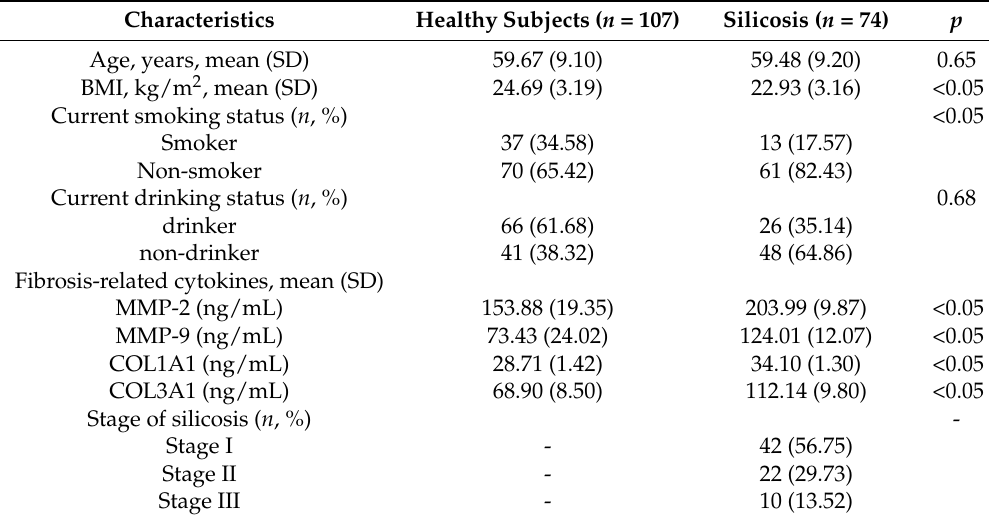
Table 1. Basic characteristics of study population.